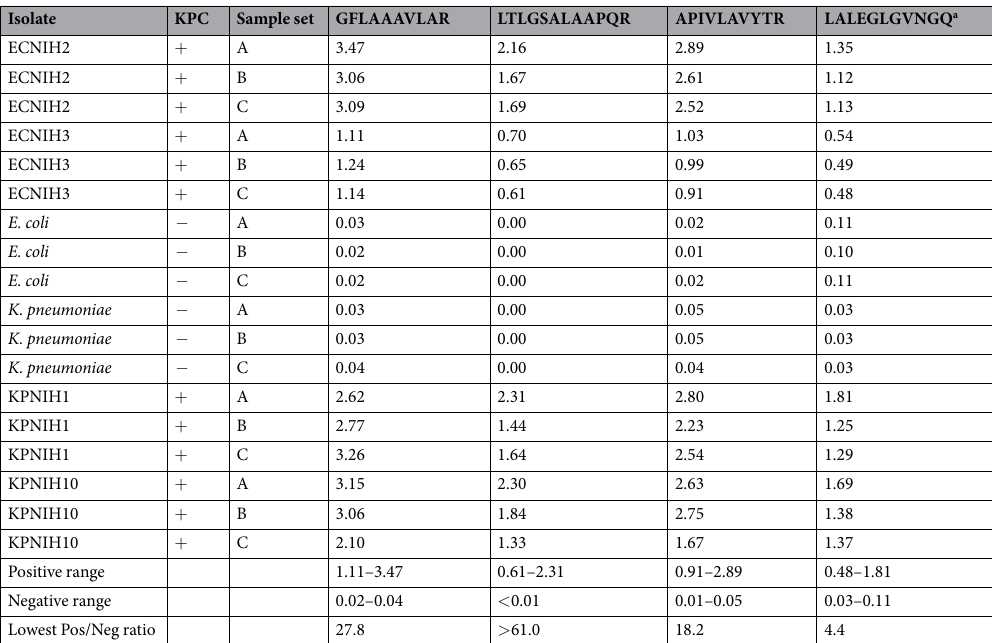
Table 3. Intensity ratios for 4 peptide markers for 6 test development set isolates. Intensity ratio is calculated as signal peak intensity/daily positive control intensity. Technical triplicate samples (A, B, and C) were prepared at the same time. a Based on b-ions only due to N or Q deamination; this peptide was not used in